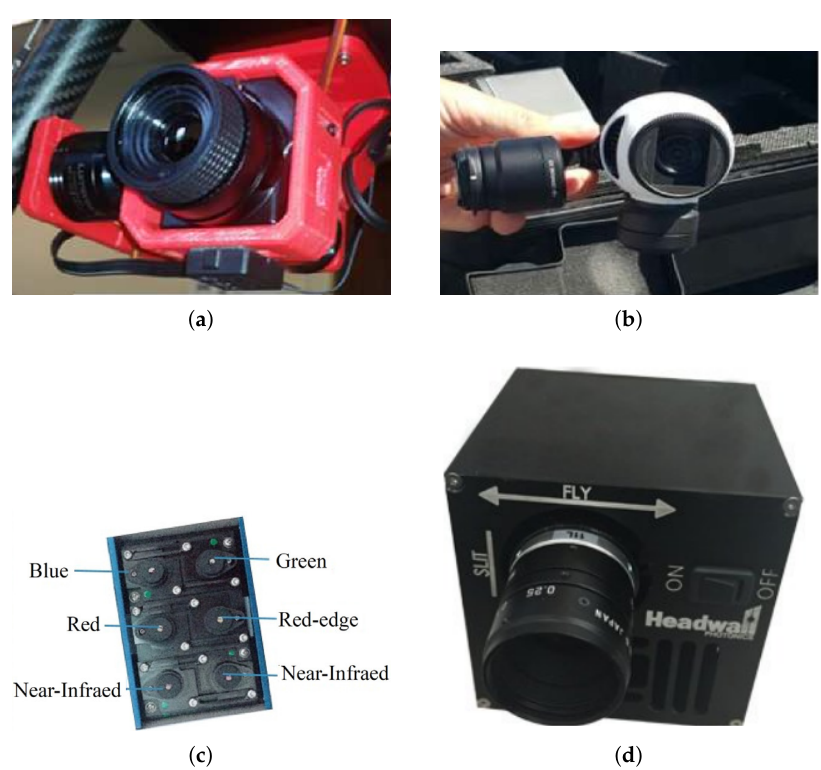
Figure 2. Examples of sensors used by UAVs for PA: ( a ) thermal sensor [103]; ( b ) RGB sensor [59]; ( c ) multispectral sensor [26]; and ( d ) hyperspectral sensor